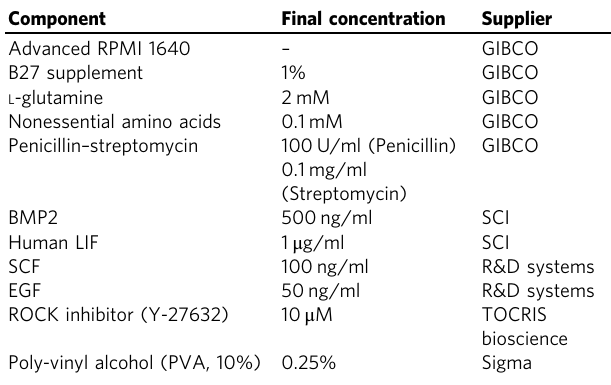
Table 2 hPGCLC medium composition.